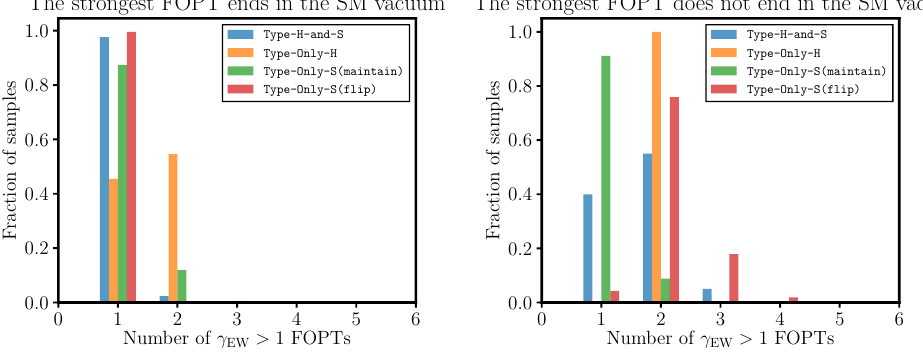
Figure 9 . Number of FOPTs with (cid:13) EW & 1 per point, for points for which the strongest FOPT ends in the SM vacuum (left panel) and does not end in the SM vacuum (right panel).